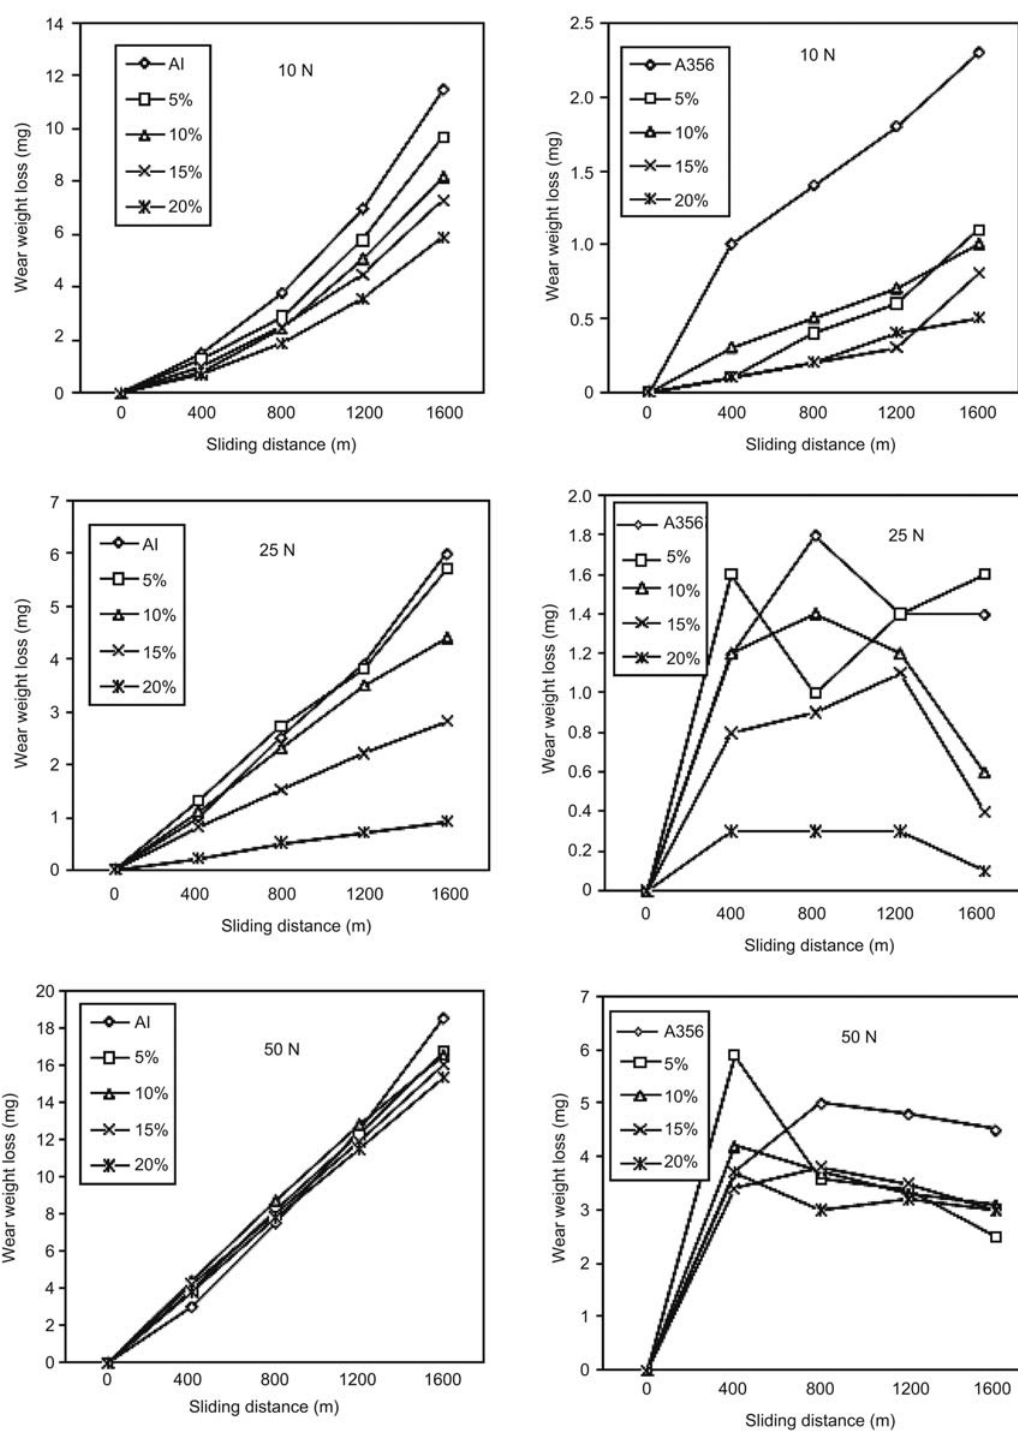
Figure 5 Weight losses of the composite materials depending on applied loads and sliding